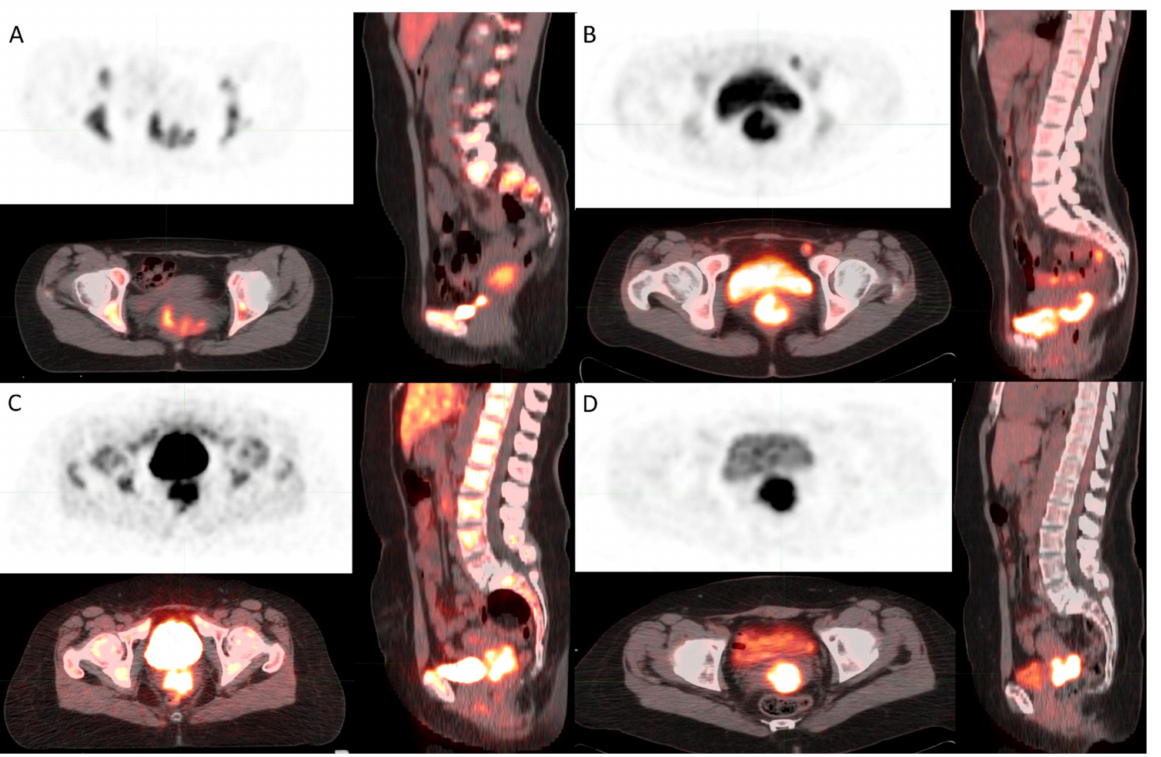
Figure 5. ( A ) [ 18 F]FLT PET image shows FLT uptake in cervical cancer in a Gram-negative pa- tient. ( B ) [ 18 F]FDG PET image shows FDG uptake in cervical cancer in a Gram-negative patient. ( C ) [ 18 F]FLT PET image shows FLT uptake in cervical cancer in a Gram-positive patient. ( D ) [ 18 F]FDG PET image shows FDG uptake in cervical cancer in a Gram-positive